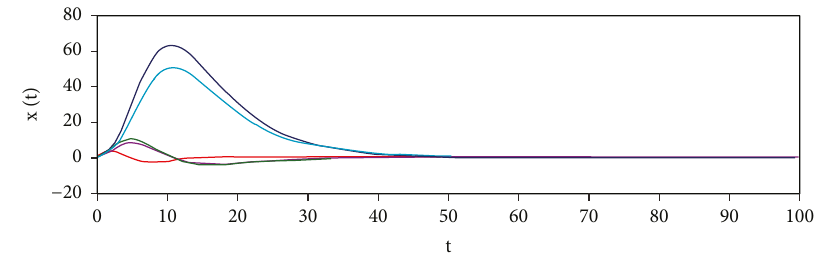
Figure 2: Stabilization via harmonic